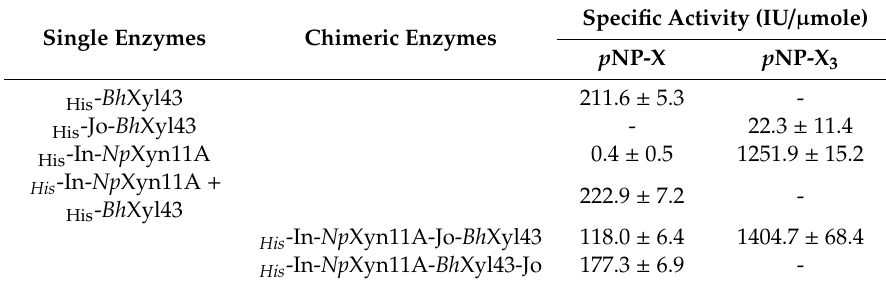
Table 2. Specific activities of Np Xyn11A and Bh Xyl43, as single enzyme or in complex.